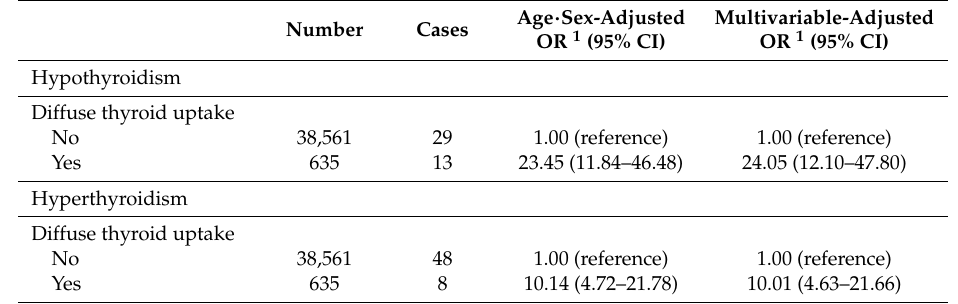
Table 2. Odds ratios 1 (95% CI) of prevalent hypothyroidism or hyperthyroidism according to diffuse thyroid uptake on